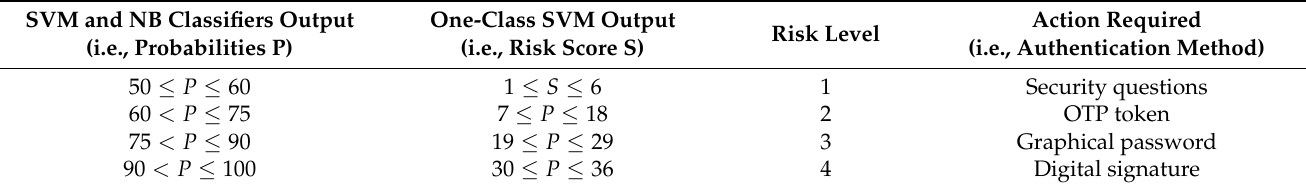
Table 2. Additional authentication methods required based on the identified risk levels